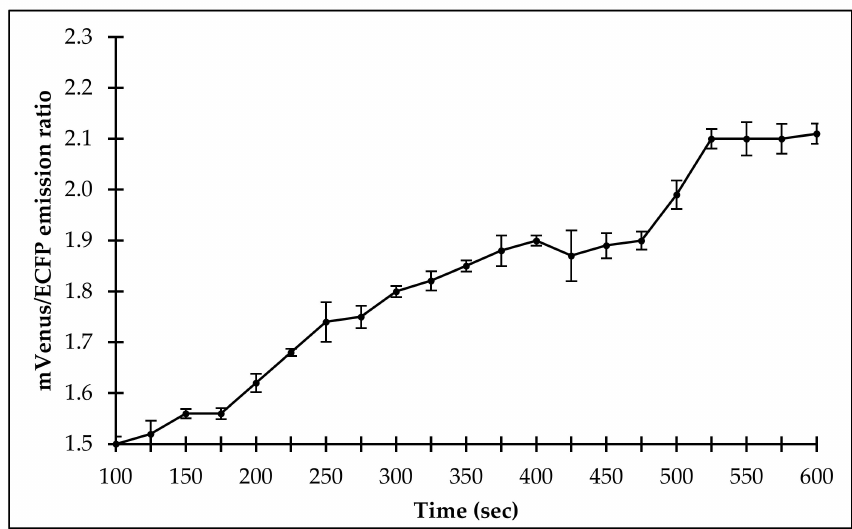
Figure 8. Real-time monitoring of sulfate levels in yeast using the FLIP-SP nanosensor. Level of sulfate in yeast cells was monitored by supplying 10 µ M of sulfate for 600 s. Values are the mean of three independent replicates. Vertical bars indicate standard errors.